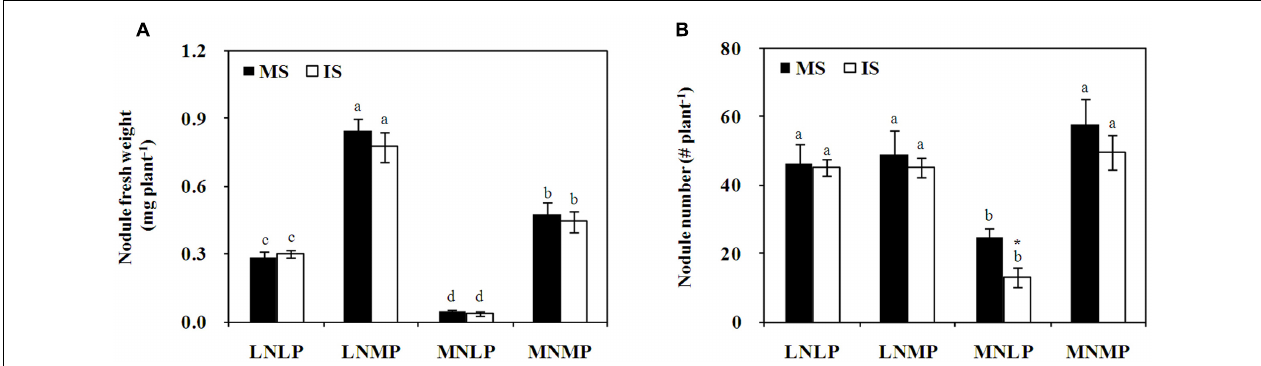
FIGURE 2 | Fresh weight (A) and numbers (B) of nodules collected from soybean reared under different N and P conditions in a greenhouse experiment. Data in the figure are the mean of four replicates with standard error. Different letters indicate significant differences among nutrient levels (Duncan’s multiple range test, P < 0.05). Asterisks indicate significant differences between monoculture and intercropping within one nutrient level (LSD test, P < 0.05). (A): nodule fresh weight; (B): nodule number. MS, monoculture soybean; IS, intercropped soybean. LNLP, low N and P; LNMP, low N and moderate P; MNLP, moderate N and low P; MNMP, moderate N and P.